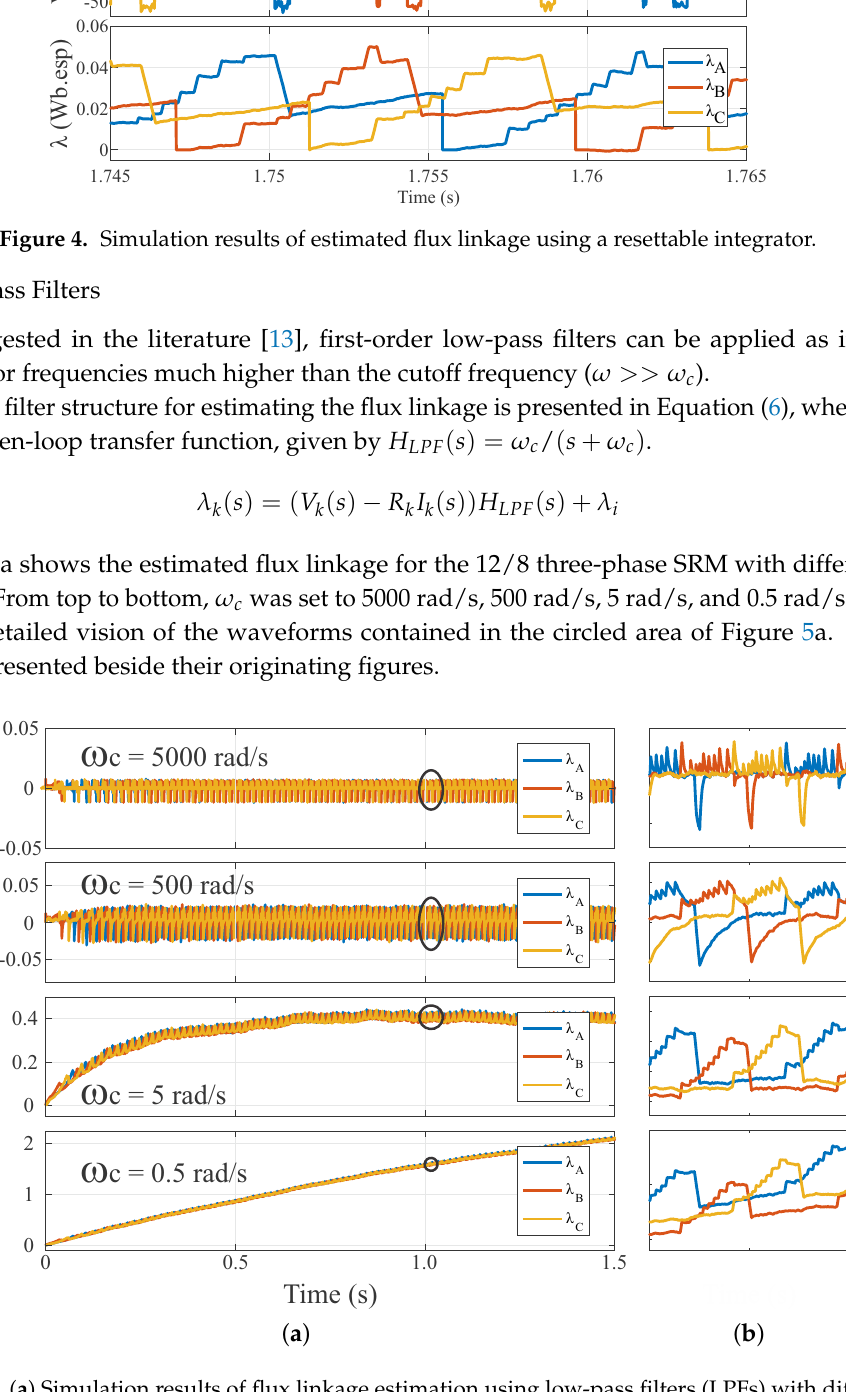
Figure 5. ( a ) Simulation results of flux linkage estimation using low-pass filters (LPFs) with different cutoff frequencies; ( b ) Details on